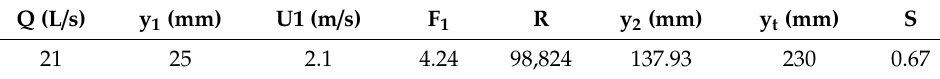
Table 1. Flow characteristics of the experimental study.